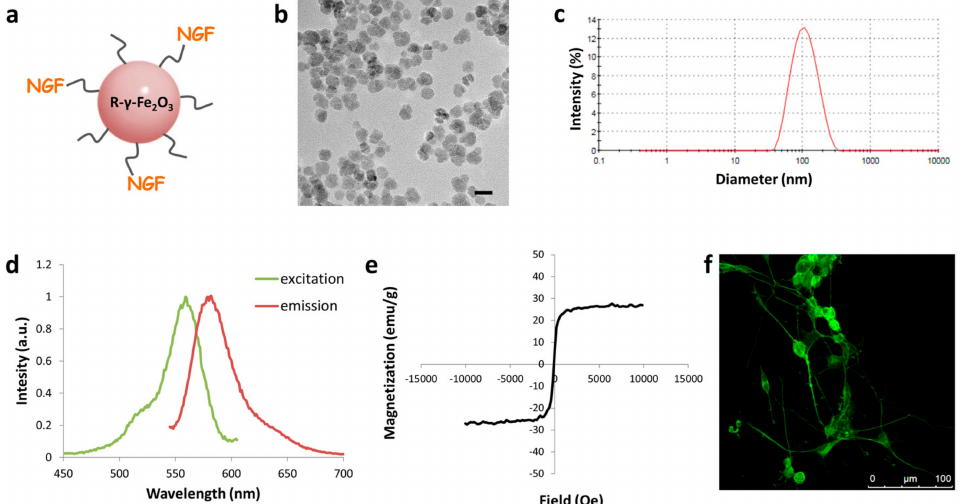
Figure 1. ( a ) Schematic illustration of nerve growth factor to iron oxide nanoparticles (NGF-MNPs); ( b ) Transmission electron microscopy image of NGF-MNPs. Scale bar = 50 nm; ( c ) Dynamic light scattering measurement of NGF-MNPs hydrodynamic diameter; ( d ) Fluorescence spectra of NGF-MNPs; ( e ) Magnetization curve of NGF-MNPs at room temperature; ( f ) PC12 cells four days after induction of differentiation by